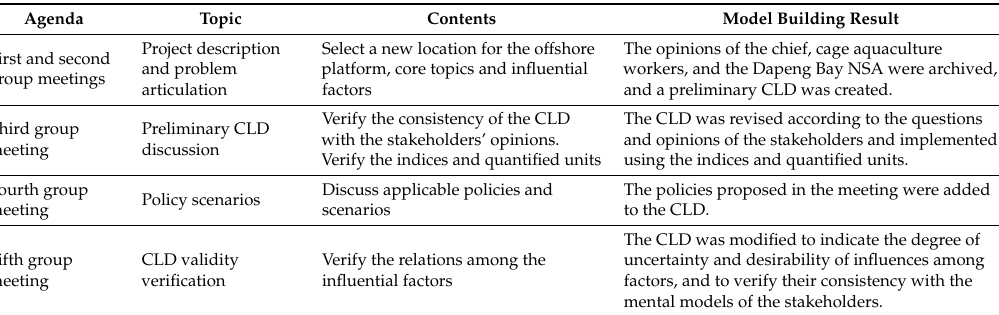
Table 1. Group Model Building (GMB)